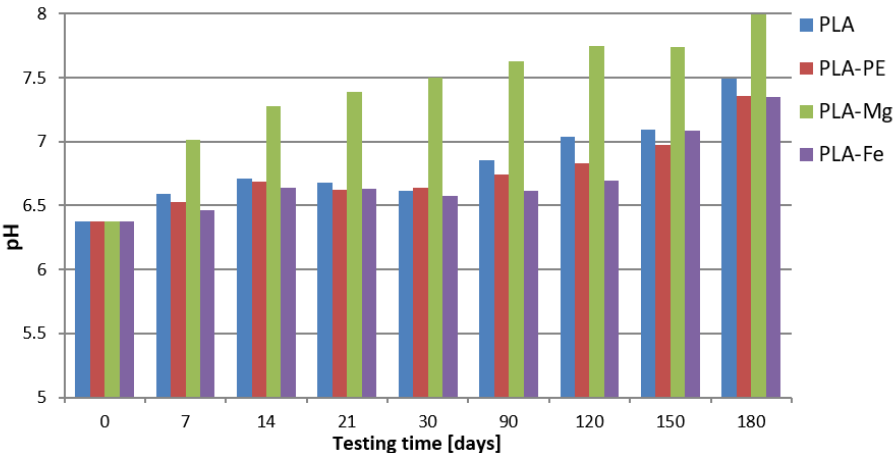
Figure 8. Results of the pH of the saline solution after materials incubation up to 180 days.